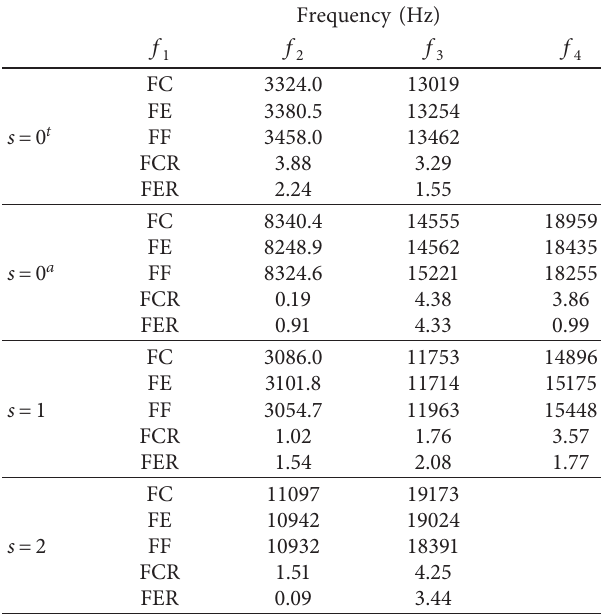
Table 3: Frequencies between 1kHz and 20kHz of HGS1 obtained by the Chebyshev–Ritz method and the experiment compared with those obtained by the finite element method.